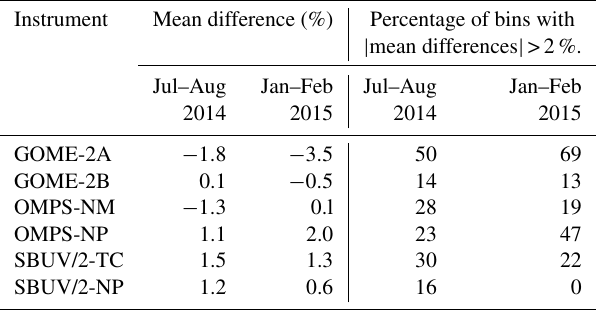
Table 2. Global diagnostics of differences in total column ozone be- tween satellite instruments and OMI-TOMS for July–August 2014 and January–February 2015. The diagnostics consists of global mean differences and percentages of non-empty SZA/latitude bins with mean differences exceeding 2% in magnitude. Instrument Mean difference (%) Percentage of bins with | mean differences | >2%.